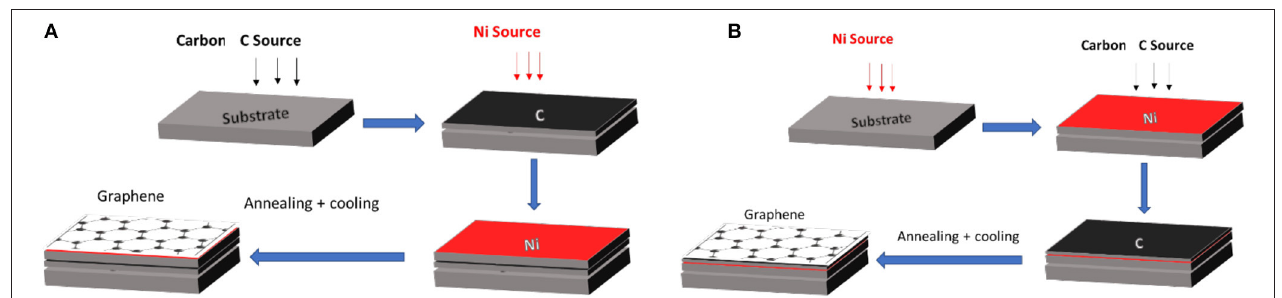
FIGURE 7 | Different stacking orders using Ni on graphene growth (A) Sequence: Ni/a-C/substrate. (B) Sequence: a-C/ Ni/substrate.